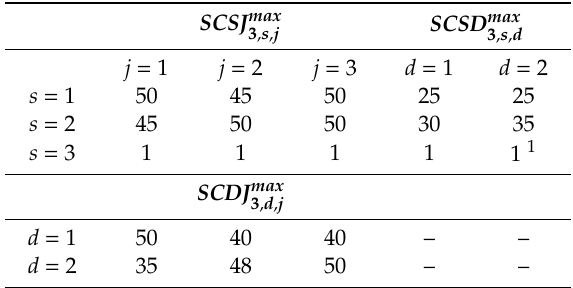
Table A21. Maximum loading capacity per shipment of product 3